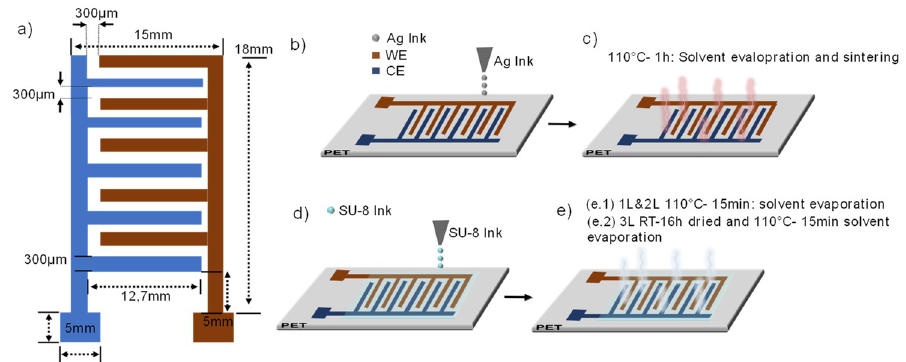
Figure 1. ( a ) Sketch and ( b - e ) manufacturing strategies for inkjet printing coplanar capacitors, showing the materials used and curing parameters for the development of the